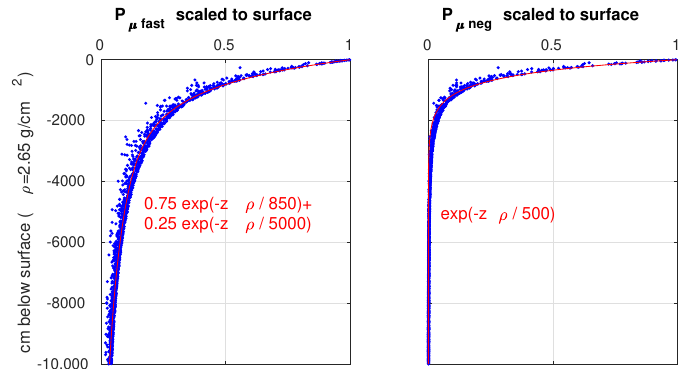
Figure 3. 10 Be muon cross sections. Fast and negative muon production rates scaled to surface values cal- culated using P_mu_total_alpha1.m [17], for 1678 land sites from ETOPO1_Bed_g_geotiff.tif [16], and random depths between 0 and 100 m below the surface (blue dots). Red lines represent the exponential decay approximations used in this